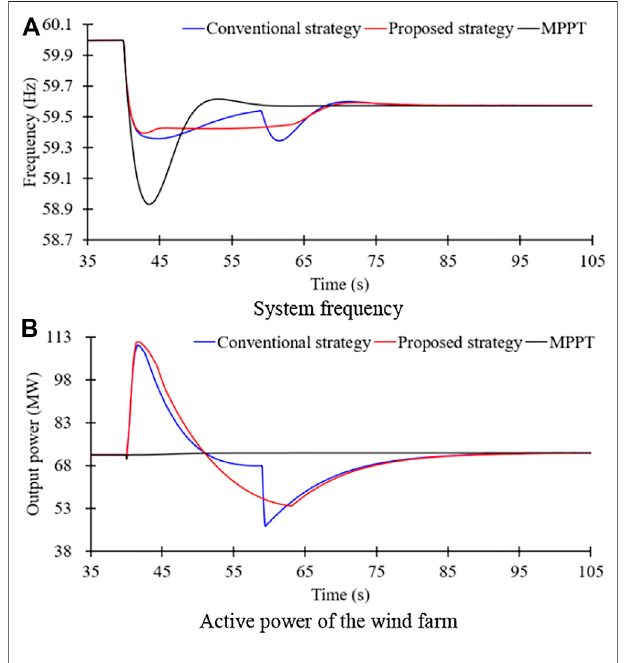
FIGURE 11 | Results for case 2.